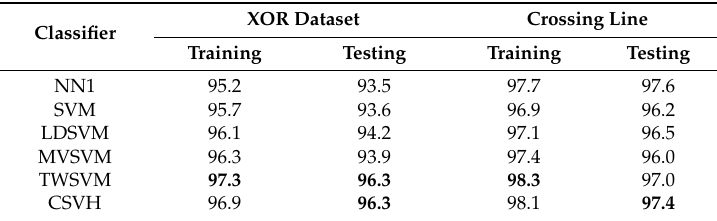
Figure 3. Cross plane dataset. Table 1. Classification accuracy of the two datasets (%).